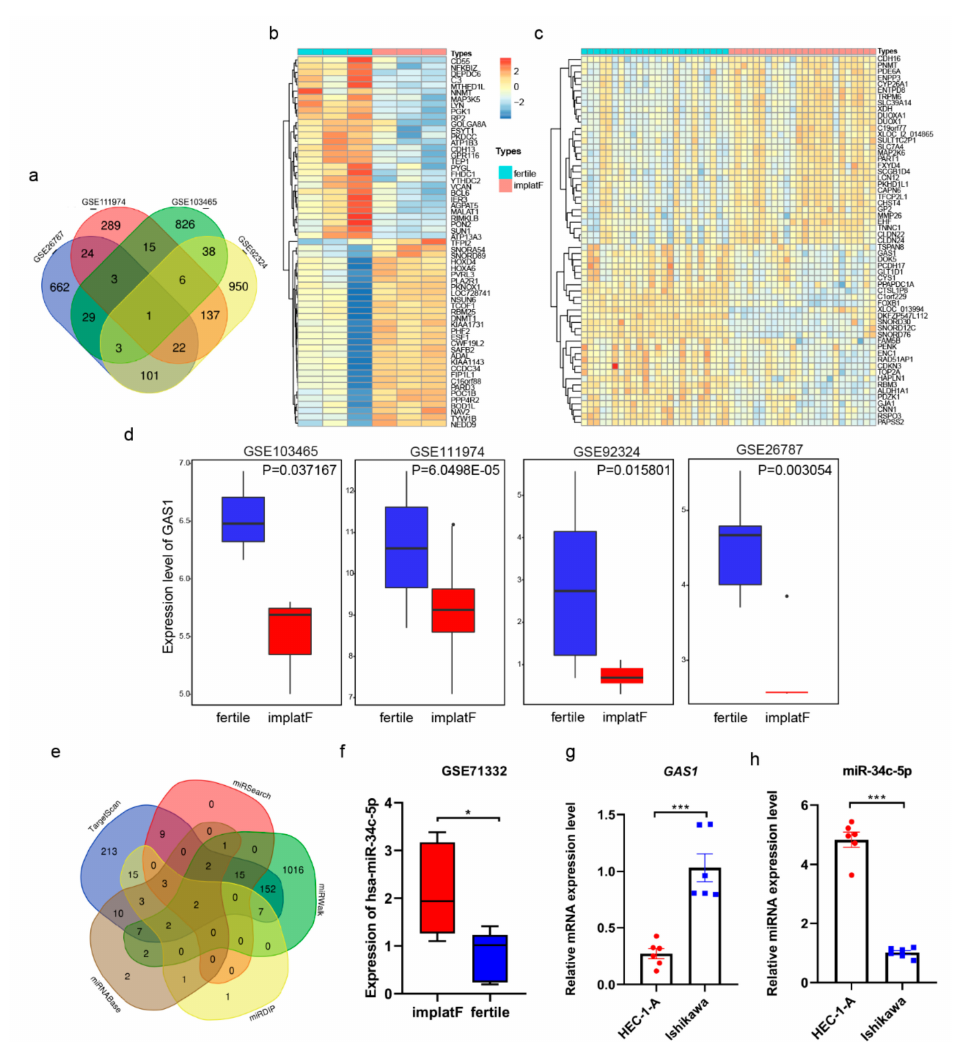
Figure 5. Growth arrest specific 1 (GAS1) was targeted by miR-34c-5p. ( a ) The Venn diagram of co-expressed di ff erentially expressed genes (DEGs) in four Gene Expression Omnibus (GEO) databases (GSE26787, GSE111974, GSE103465, and GSE92324): only one gene, GAS1, was observed. ( b , c ) Heat maps show the top 60 di ff erentially expressed genes in GSE103465 and GSE111974, respectively. ( d ) The expression of GAS1 in four gene microarrays. ( e ) The comparison of target miRNA of GAS1 predicted by TargetScan, miRSearch, miRTarBase, miRWalk, and mirDIP. ( f ) The expression of hsa-miR-34c-5p in miRNA expression chip GEO: GSE71332 of RIF. ( g ) The mRNA level of GAS1 in Ishikawa and HEC-1-A cell lines. ( h ) The expression of miR-34c-5p in Ishikawa and HEC-1-A cell lines. * P < 0.05, *** P <